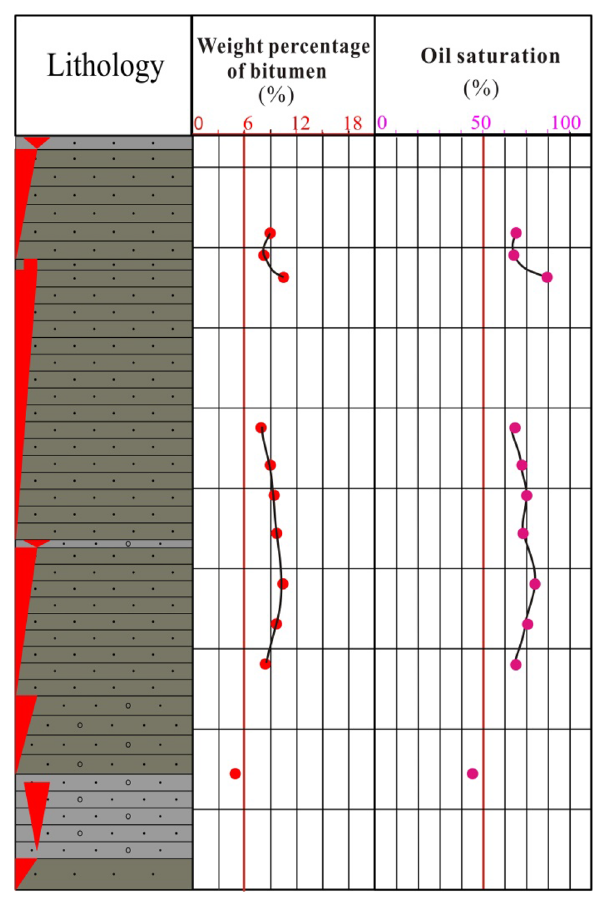
Fig. 5 Analysis results of weight percentage of bitumen and oil satu- ration with sealed